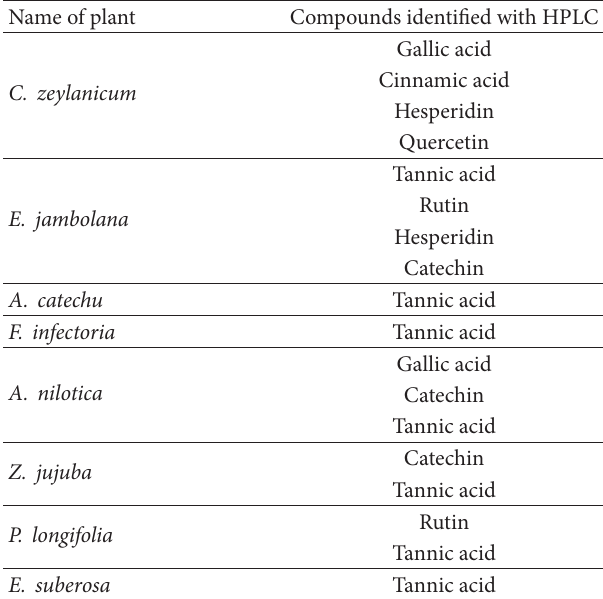
Table 3: Compounds identified by HPLC in selected medicinal